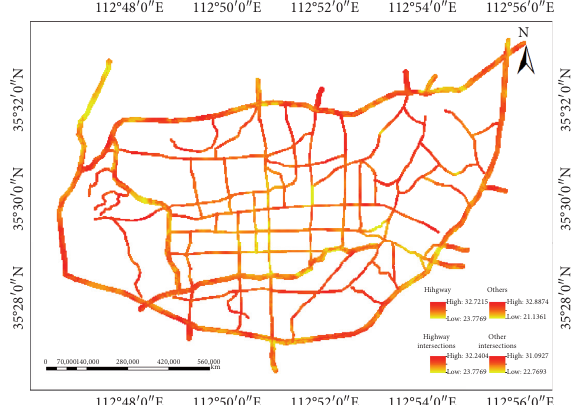
Figure 4: LST of Jincheng road network area in 2013.